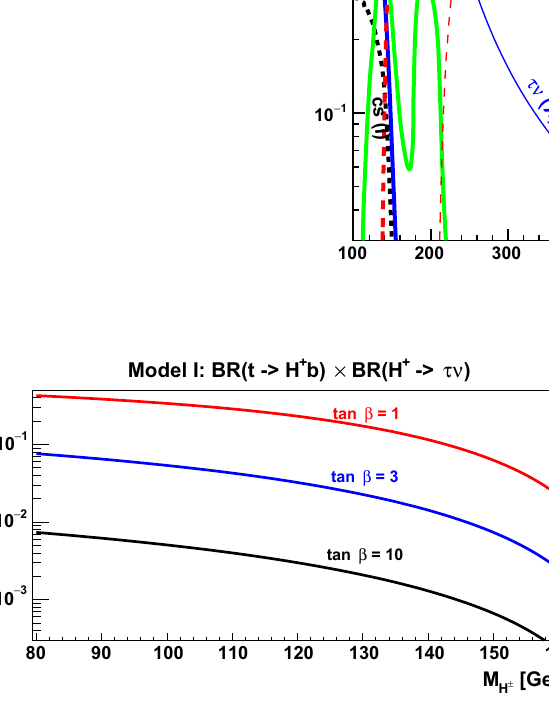
Fig. 5 Product of branching ratios, BR ( t → H + b ) × BR ( H + → τ + ν) , for Model I, and three values of tan β , as